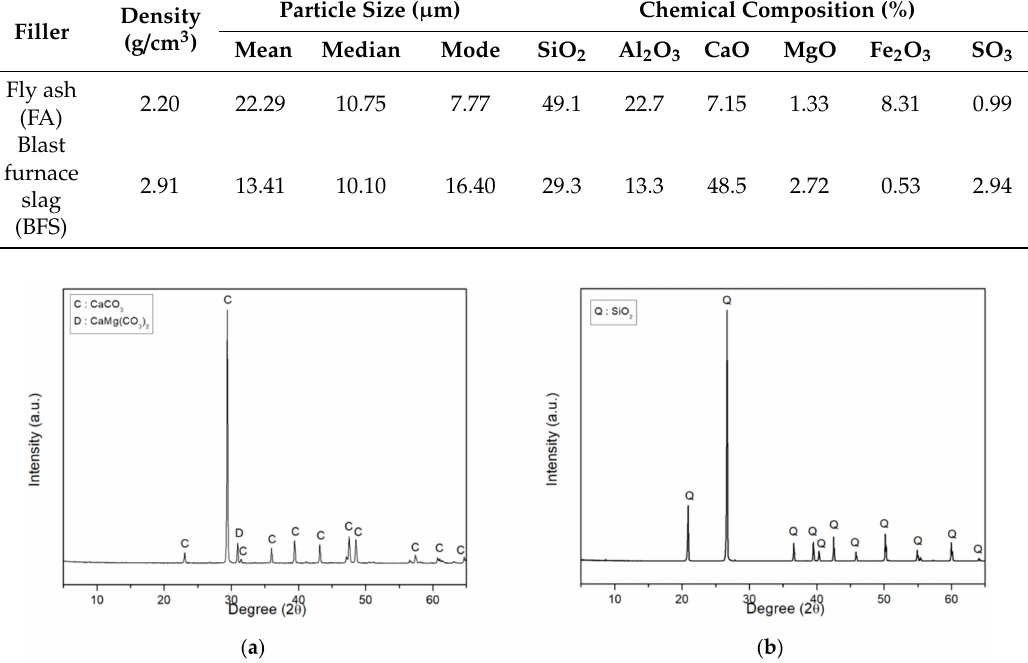
Figure 1. X-ray di ff raction (XRD) spectra of the crystalloid fillers: ( a ) Ground calcium carbonate; ( b ) Silica flour.